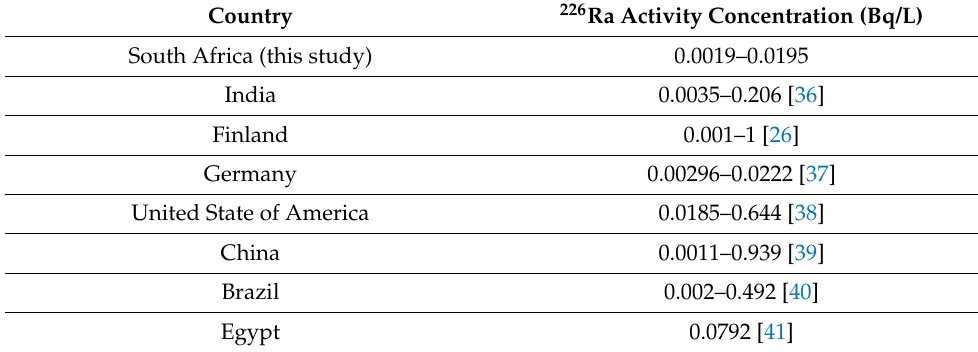
Figure 4. The 238 U activity concentration relative to 226 Ra (radiogenic product). Table 2. 226 Ra activity concentrations in drinking water from around the world.